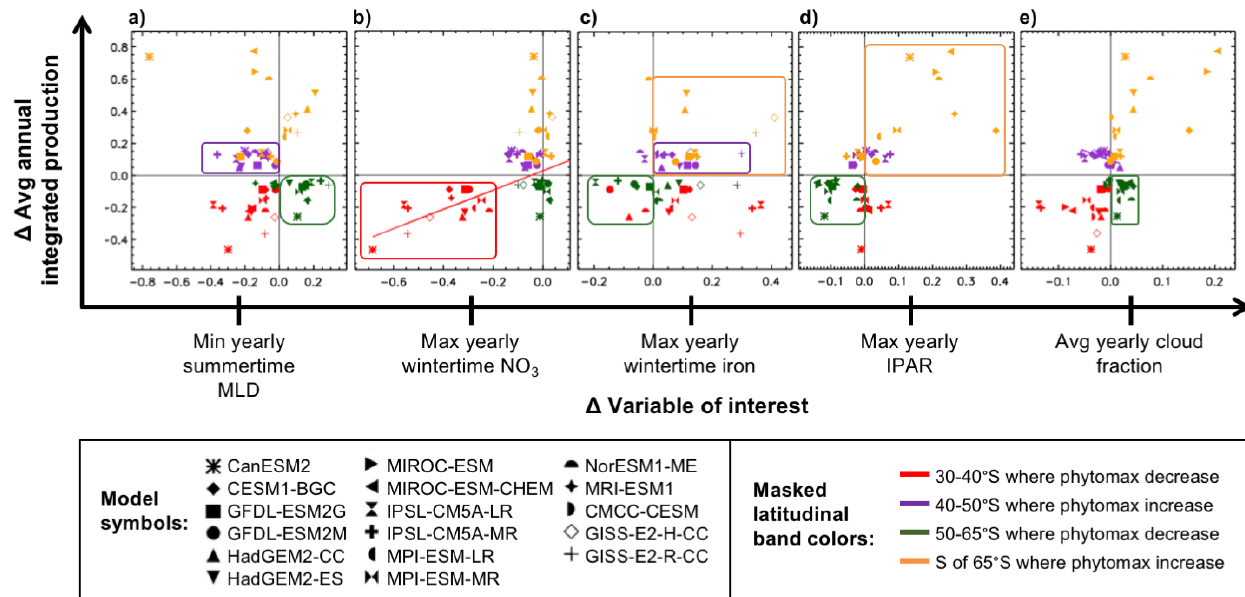
Figure 4. Drivers of 100-year phytoplankton productivity changes across CMIP5 models, by model and latitudinal band. Scatter plots of each model’s 100-year relative change in PP versus its corresponding relative change in the listed variable within each zonal band. Each colour represents a different zonal band, while each symbol represents a different model. Coloured boxes enclose points which behave in line with our expectations and proposed mechanisms based on Figs. 1–3. Best-fit lines are drawn only when correlations are significant ( p < 0 .